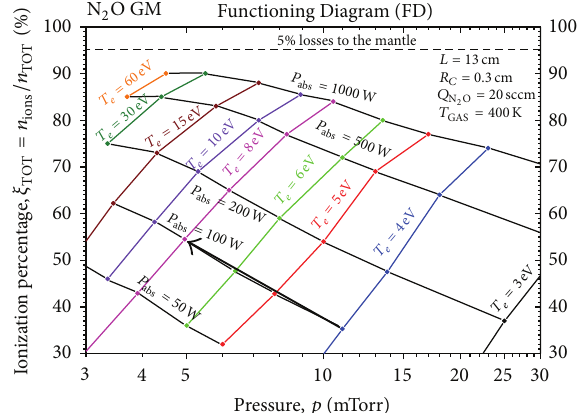
Figure 14: As in Figure 13 but for 20sccm flow rate.